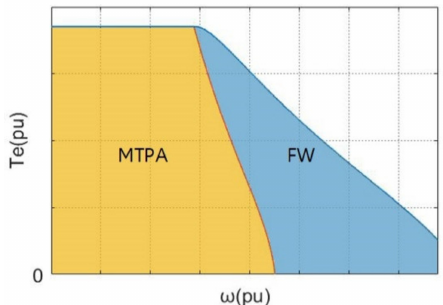
Figure 1. IPMSM operating